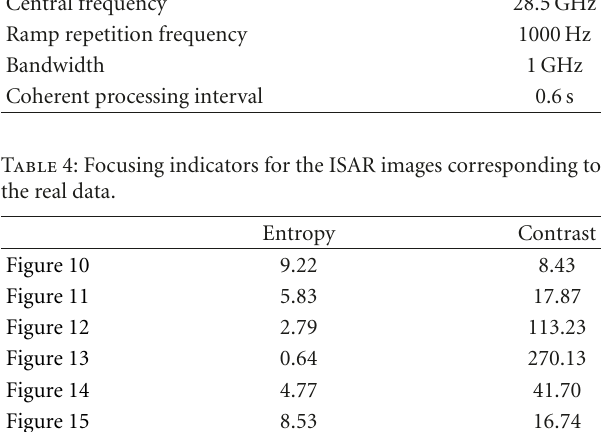
Table 3: Radar parameters for the live acquisition. Radar type